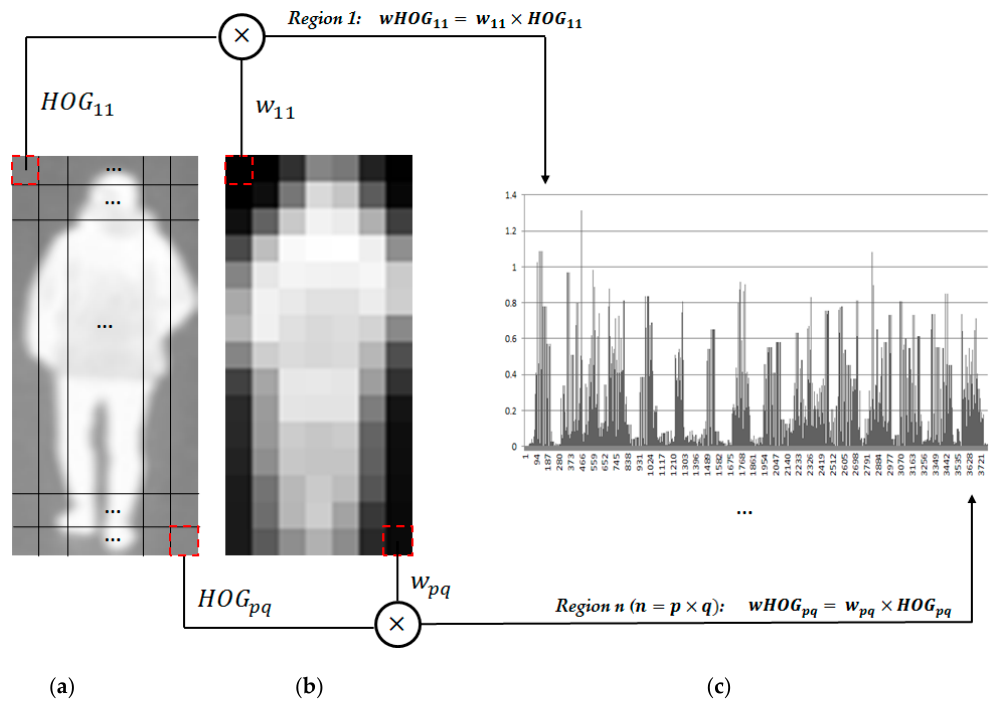
Figure 4. Demonstration of methodology for extracting the wHOG feature by combining the HOG features of images and weighted values of corresponding sub-blocks: ( a ) input image; ( b ) quality measurement map (MEAN map or STD map); and ( c ) the wHOG feature by combining ( a ) and ( b ).